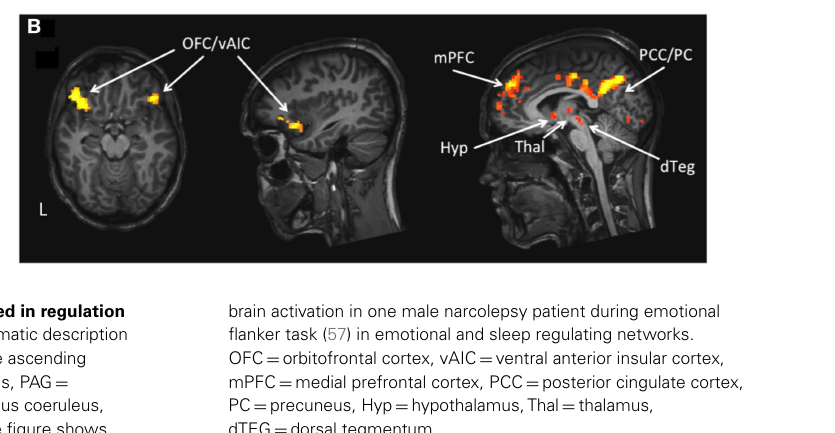
brain activation in one male narcolepsy patient during emotional flanker task (57) in emotional and sleep regulating networks. OFC = orbitofrontal cortex, vAIC = ventral anterior insular cortex, mPFC = medial prefrontal cortex, PCC = posterior cingulate cortex, PC = precuneus, Hyp = hypothalamus,Thal = thalamus, dTEG = dorsal